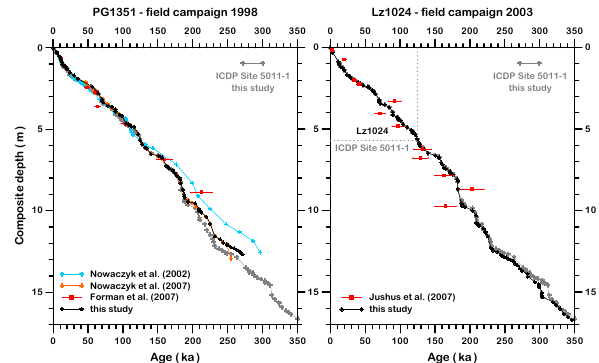
Fig. 8. Age depth models for pilot cores PG1351 (1998) and Lz1024 (2003) after synchronizing with ICDP Site 5011-1 age model (Fig. 7). Red squares with error bars mark results from in- frared stimulated luminescence (IRSL) dating. The dotted line in the right graph mark the junction between Lz1024 and the ICDP Site 5011-1 composite record, assembled from cores 5011-1A, -1B, and